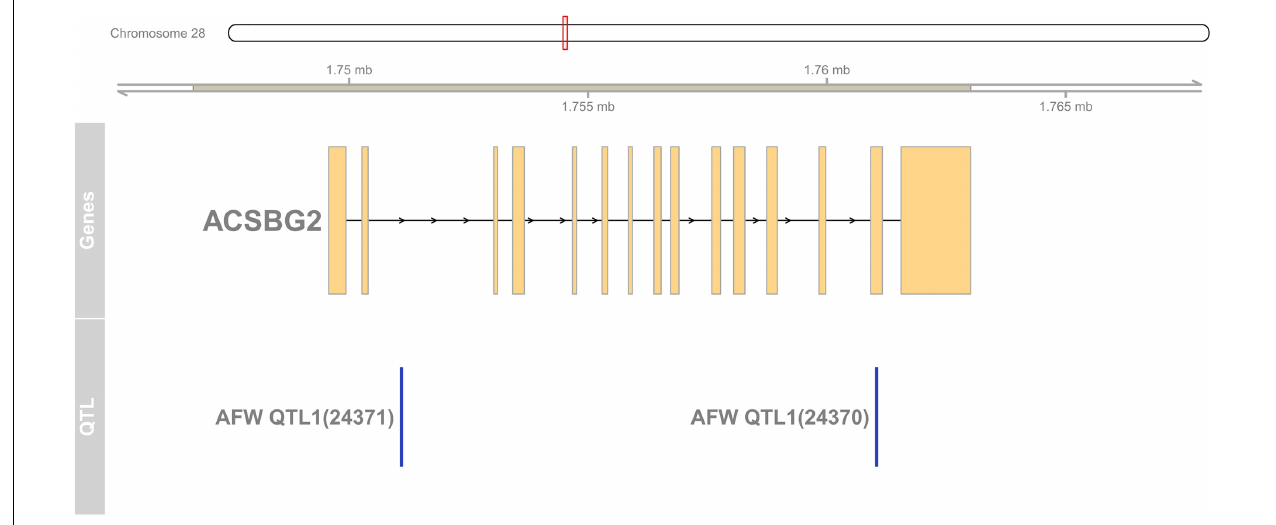
FIGURE 6 | The region of ACSBG2 covers two chicken abdominal fat weight QTLs in chromosome 28. QTL, quantitative trait loci.